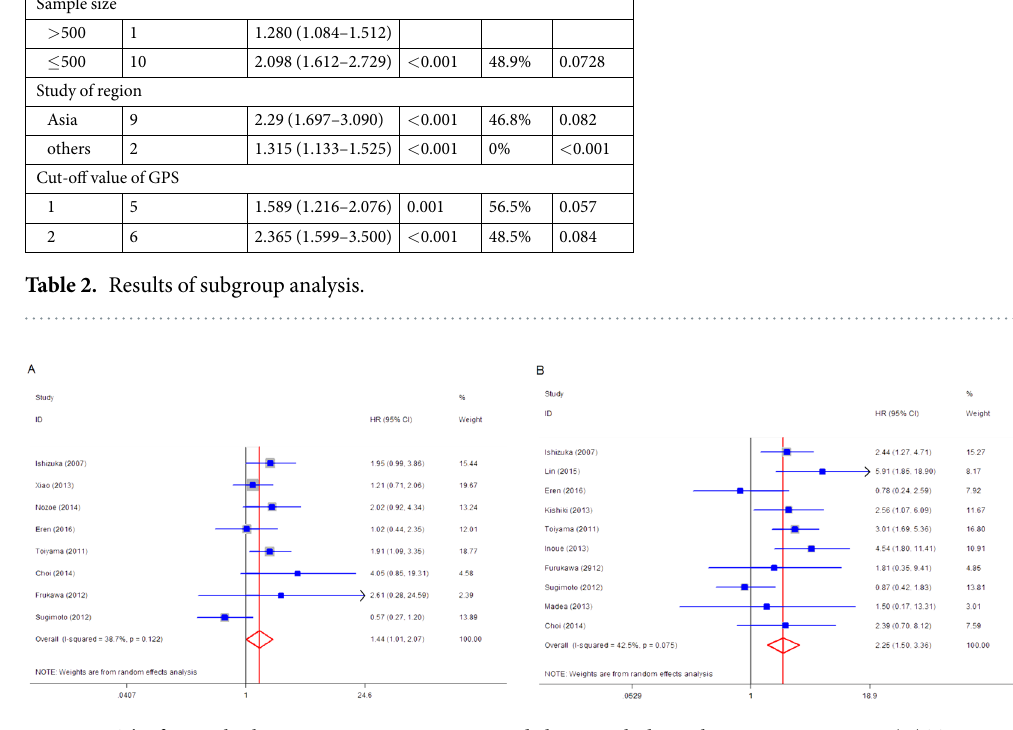
Figure 3. The forest plot between pretreatment GPS and clinicopathological parameters in CRC. ( A ) TNM stage (III, IV vs 0, I, II); ( B ) serum